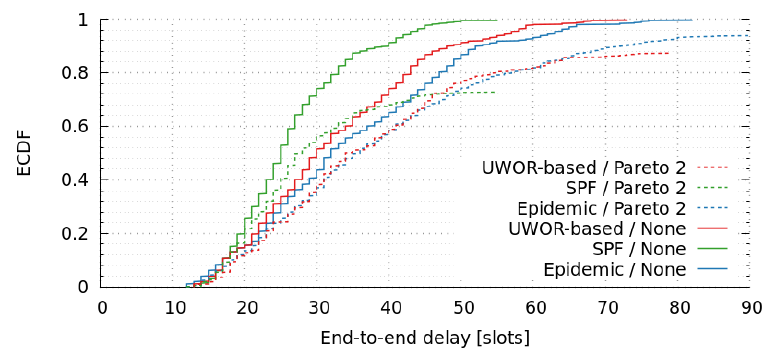
Figure 10. End-to-end message